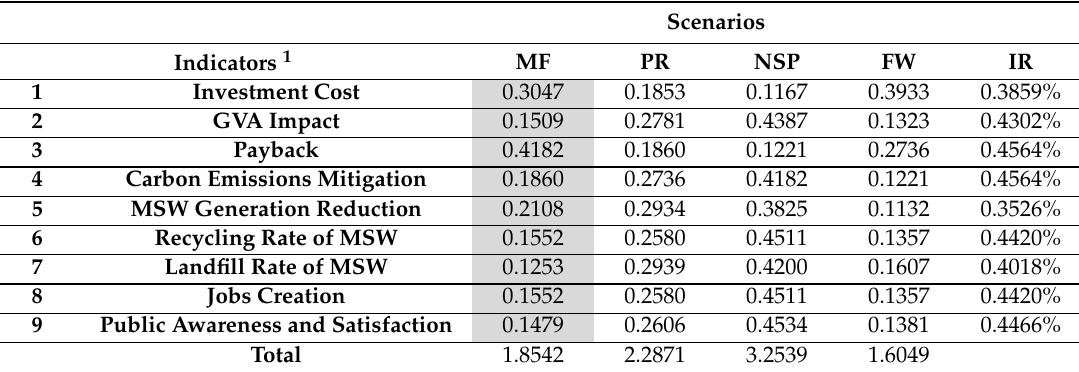
Table 10. Objective weight matrix for the CE